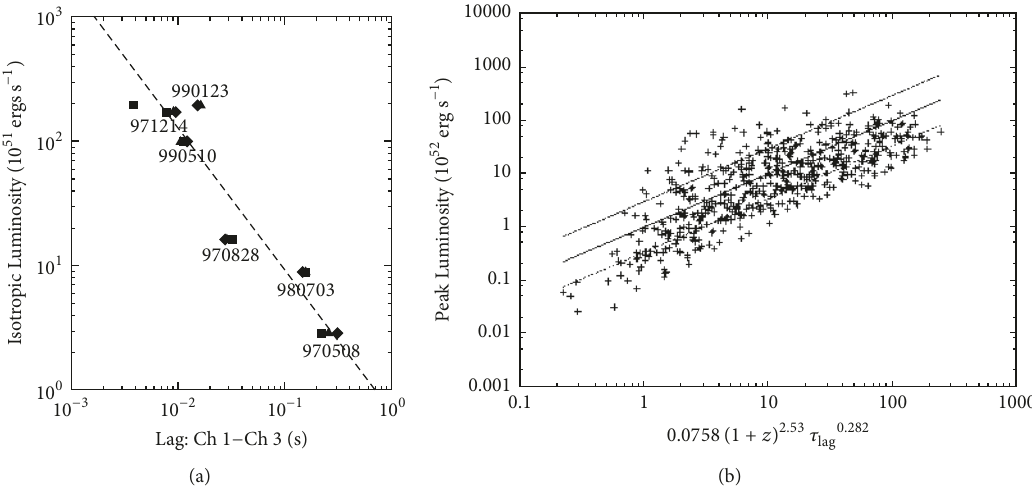
Figure 2: (a) 𝐿 versus 𝜏 ∗ distribution for six GRBs with measured redshifts. The dashed line represents the power law fit to the lag peak lag ∼ −1.14 log (𝜏 ∗ /0.01 s ) . The lag time is times for ranges consisting of count rates larger than 0.1 × peak intensity (squares), yielding log 𝐿 peak lag computed using channel 1 (25 – 50 keV ) and channel 3 (100 – 300 keV ) of the BATSE instrument. (Figure after Norris et al. [113]; see Figure 6 therein. @ AAS. Reproduced with permission.) (b) The 𝐿 - 𝜏 distribution in the log 𝐿 versus ∼ 2.53 log (1 + 𝑧) − 0.282 log 𝜏 plane. peak lag peak lag The correlation coefficient is 𝜌 = 0.77 , 𝑃 = 7.9 × 10 −75 . The solid line represents the best-fit line and two dashed lines delineate 1𝜎 deviation. (Figure after Tsutsui et al. [128]; see Figure 4 therein. Copyright @ 2008 AIP Publishing.)